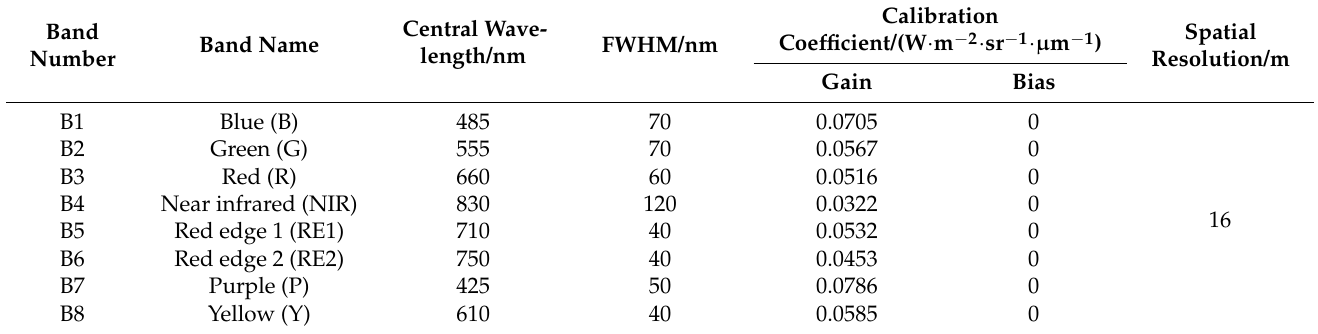
Table 1. Main parameter information of GF-6 WFV data in 2019.